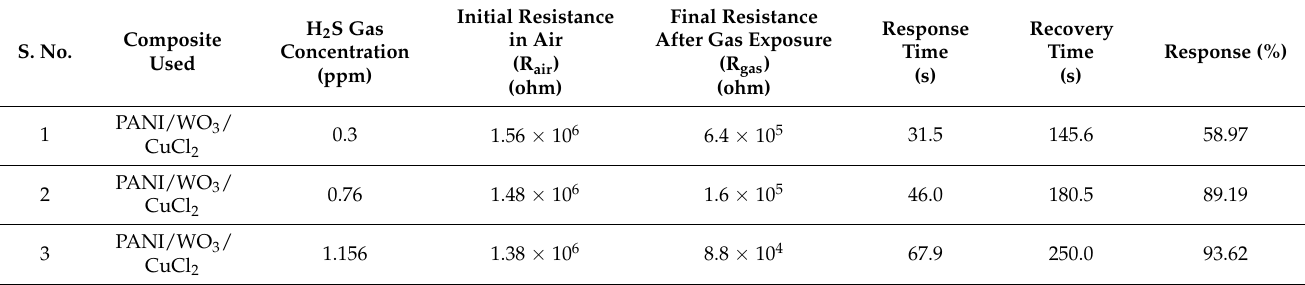
Table 2. Response and recovery behavior of PANI/WO 3 / CuCl 2 film - based sensor when exposed to H 2 S